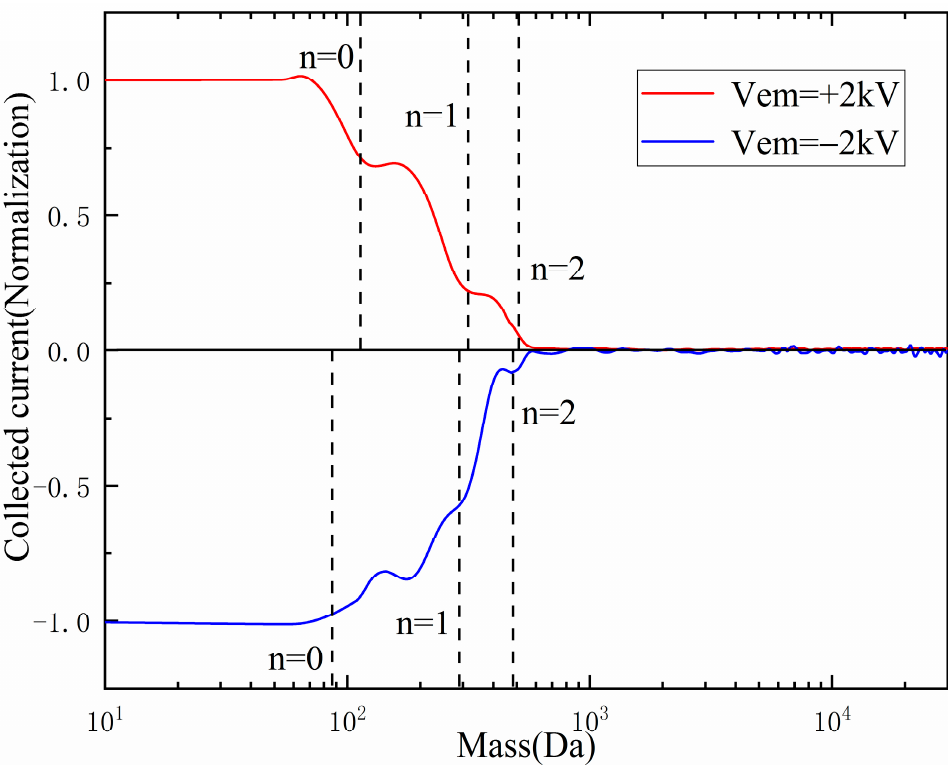
Figure 14. Measured emitted ion mass distribution ( V em = ±2 kV).